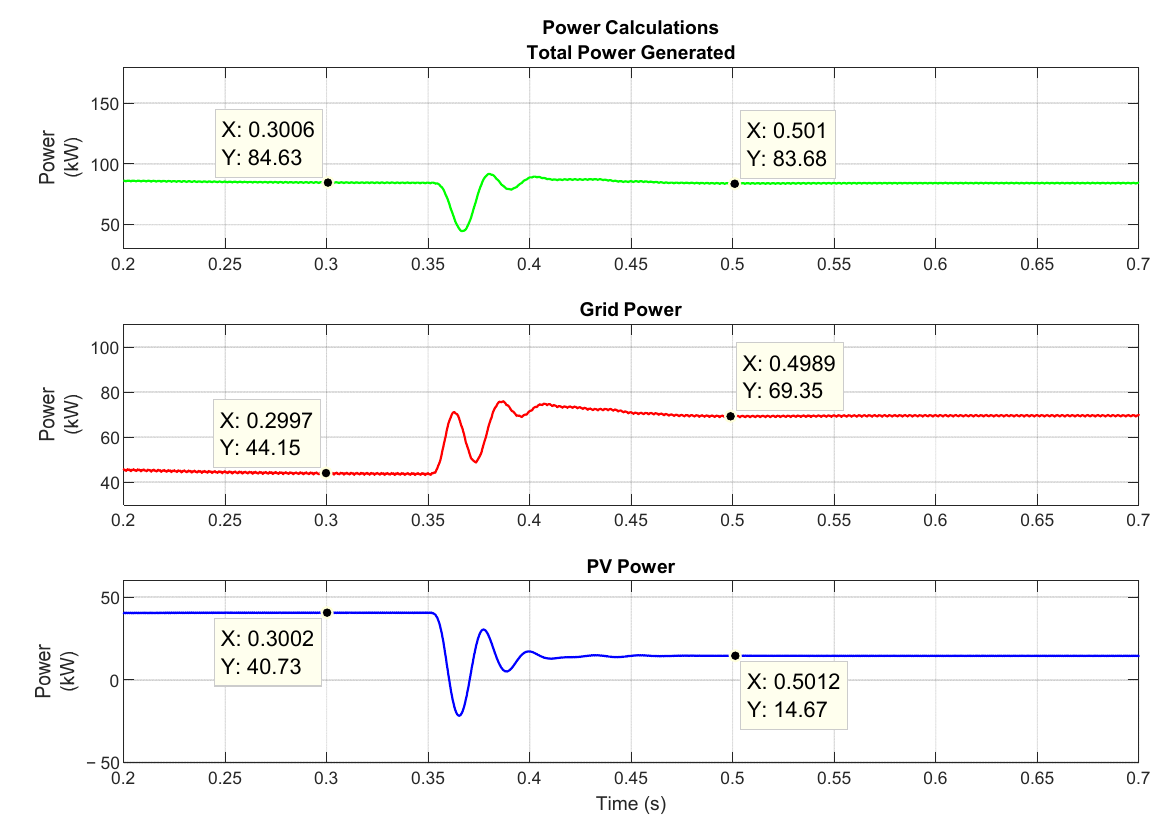
Energies 2021 , 14 , x FOR PEER REVIEW Figure 14. Total power generated and contribution of grid power and PV power, before and after the step change. The total power consumed and the share of the battery, load 1 and load 2 is shown in Figure 15. It can be seen that the sum of power consumed by the battery, load 1 and load 2 is equal to the total consumed power.